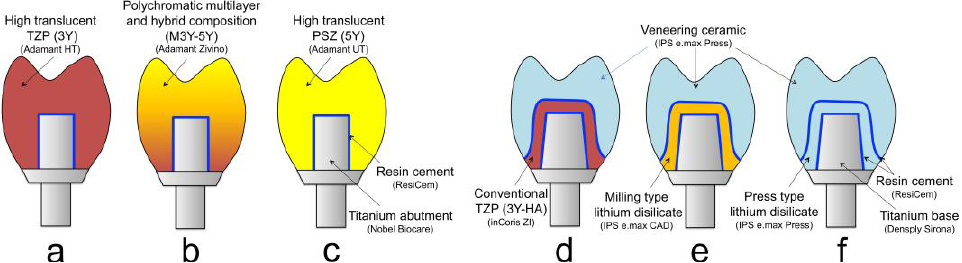
Figure 14. Illustration of fracture test specimens for the superstructure of monolithic zirconia